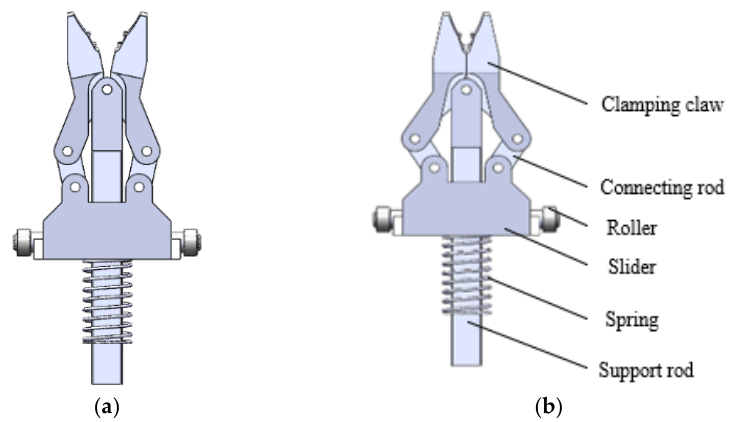
Figure 8. Structure of the clamping unit: ( a ) open state, and ( b ) closed state.